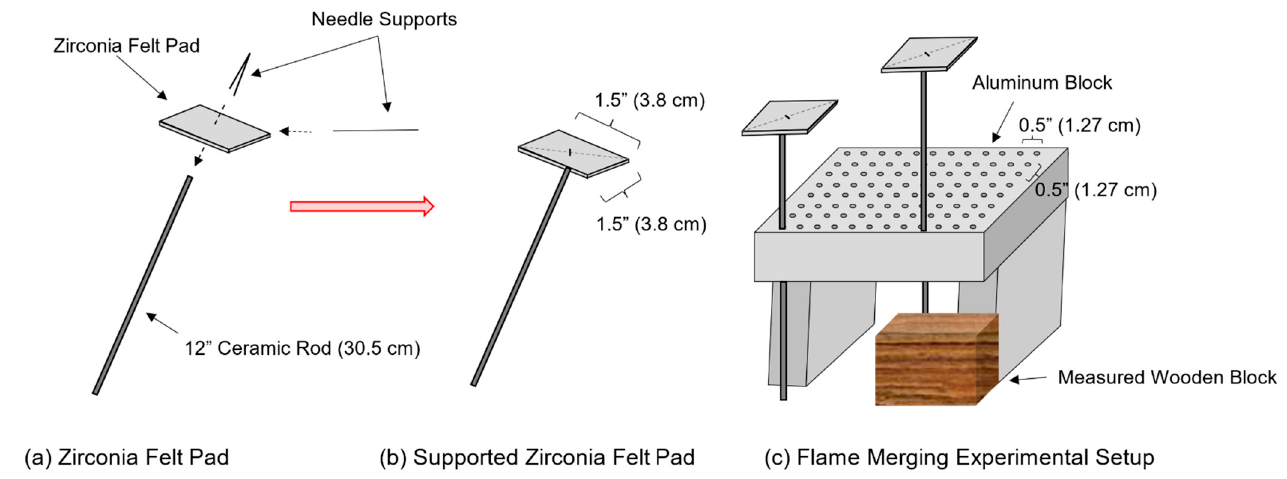
Figure 1. Schematic of the flame merging experimental setup.